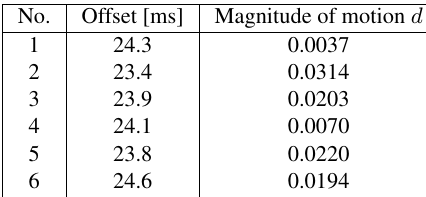
Table 1. Results of the offset computation prior to data